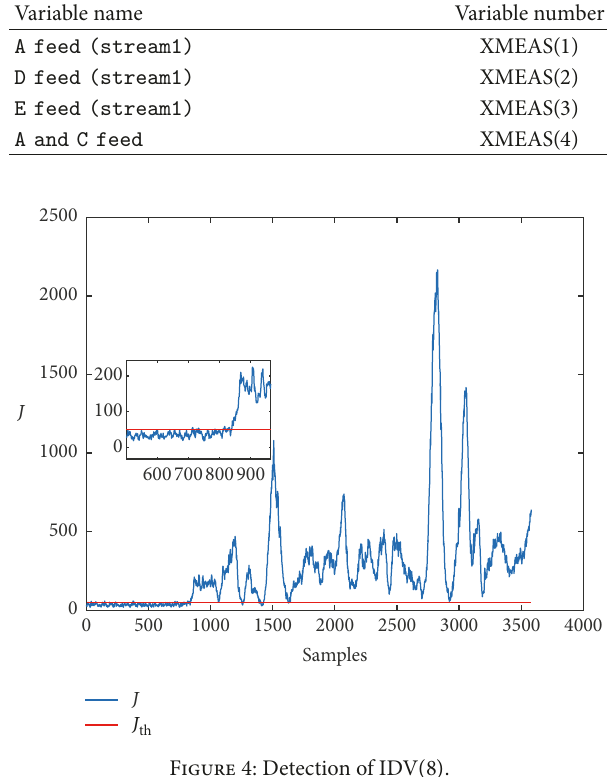
Figure 4: Detection of IDV (8) .